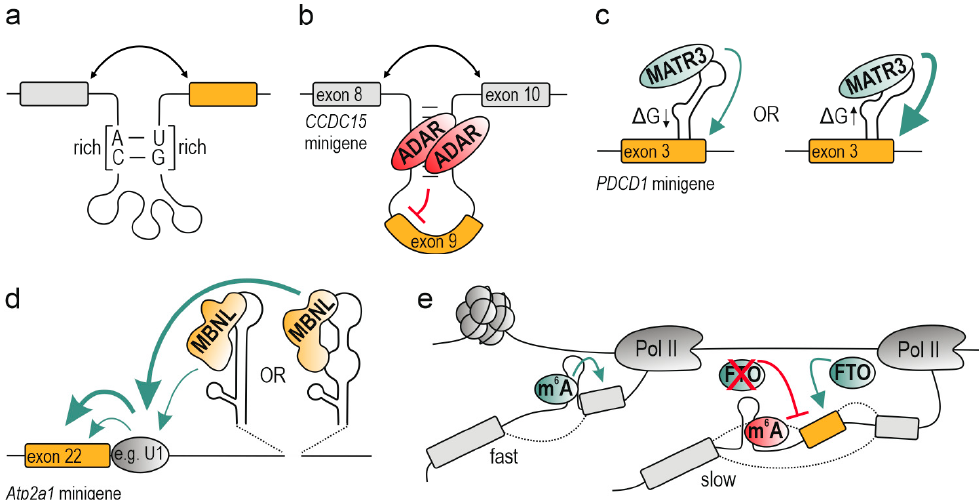
Figure 3. Schematic diagrams showing different mechanisms of AS regulation by RNA structural arrangement. RNA structural arrangement may mediate AS via: ( a ) bridging cis -acting elements [42]; ( b ) looping out alternative exons or cis -acting elements [140]; ( c ) blocking/promoting interaction with splicing factors [167]; ( d ) allosteric activation/inhibition of splicing factors [172]; ( e ) modulating the splicing kinetics [126]. Detailed explanation can be found in the main text. Alternative exons are in orange; constitutive exons are in grey. CCDC15 , coiled-coil domain containing 15 transcript; MATR3, Matrin-3 protein; Δ G, the change in Gibbs free energy, serves as a measure of thermodynamic stability of RNA secondary structure; PDCD1 , programmed cell death 1 transcript; Atp2a1 , ATPase sarcoplasmic/endoplasmic reticulum Ca2+ transporting 1 transcript; U1, small nuclear ribonucleoprotein U1 (U1 snRNP); Pol II, RNA polymerase II; FTO, RNA m 6 A demethylase.